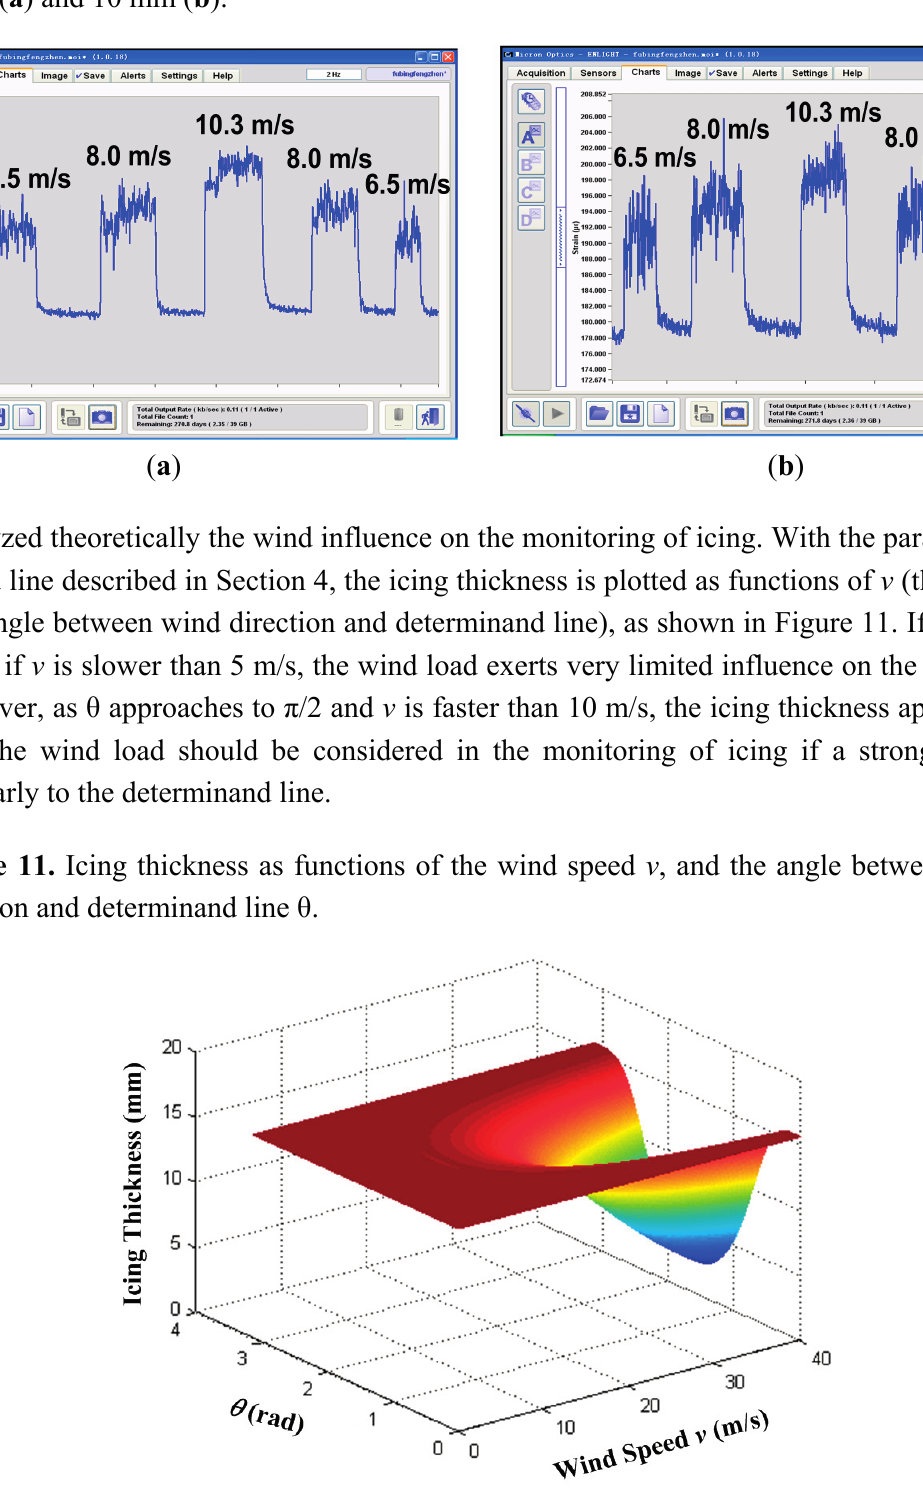
Figure 10. FBG strains measured at different wind speeds, with artificial icing thickness of 3 mm ( a ) and 10 mm ( b ).